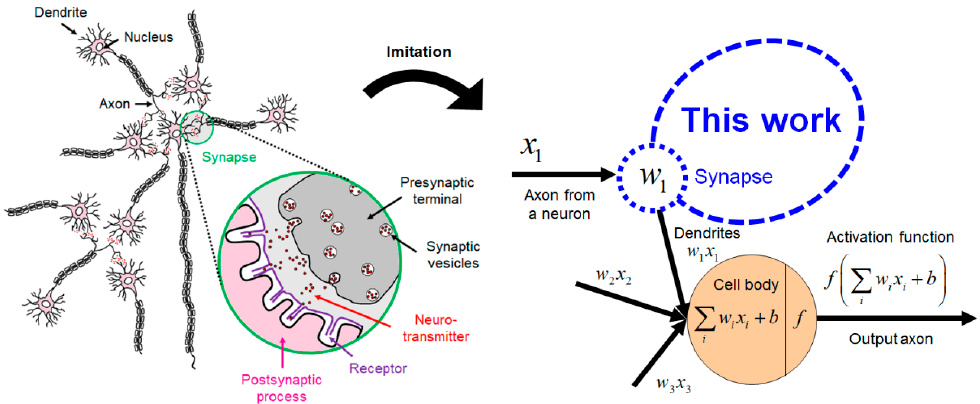
Figure 1. Biological nerve cell element targeted to imitate by the electron device in this work and its mathematical representation.